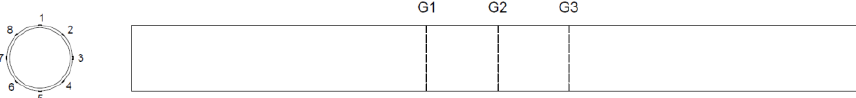
Figure 16. Full-size SCR test specimen. Figure 17. Weld diagram.